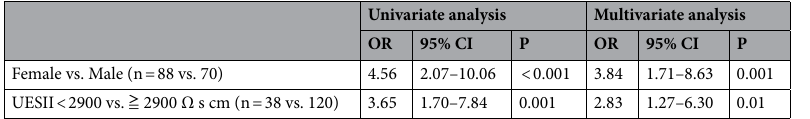
Table 3. Predictors of reflux symptom index (RSI) > 13 in this study cohort analyzed by univariate and multivariate logistic regression